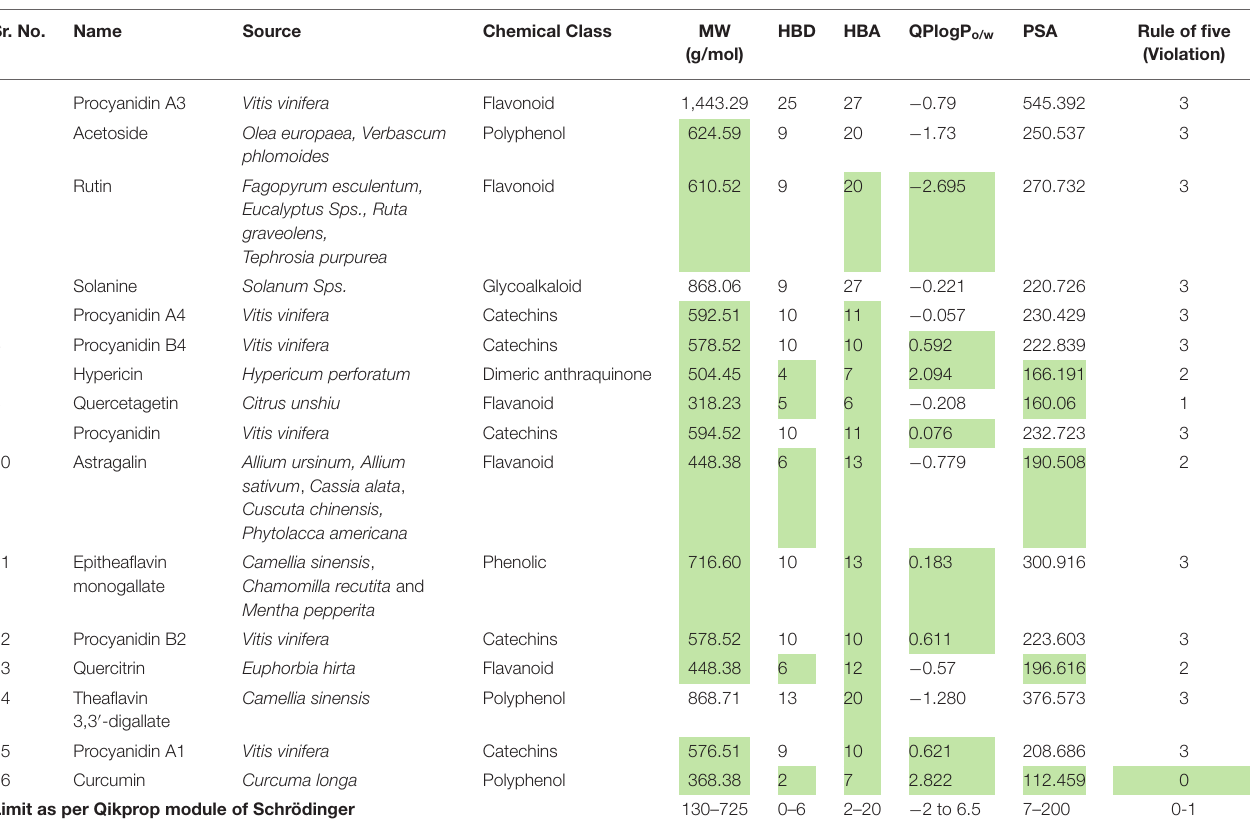
TABLE 3 | Predicted physicochemical parameters of phytoconstituents a . Sr.